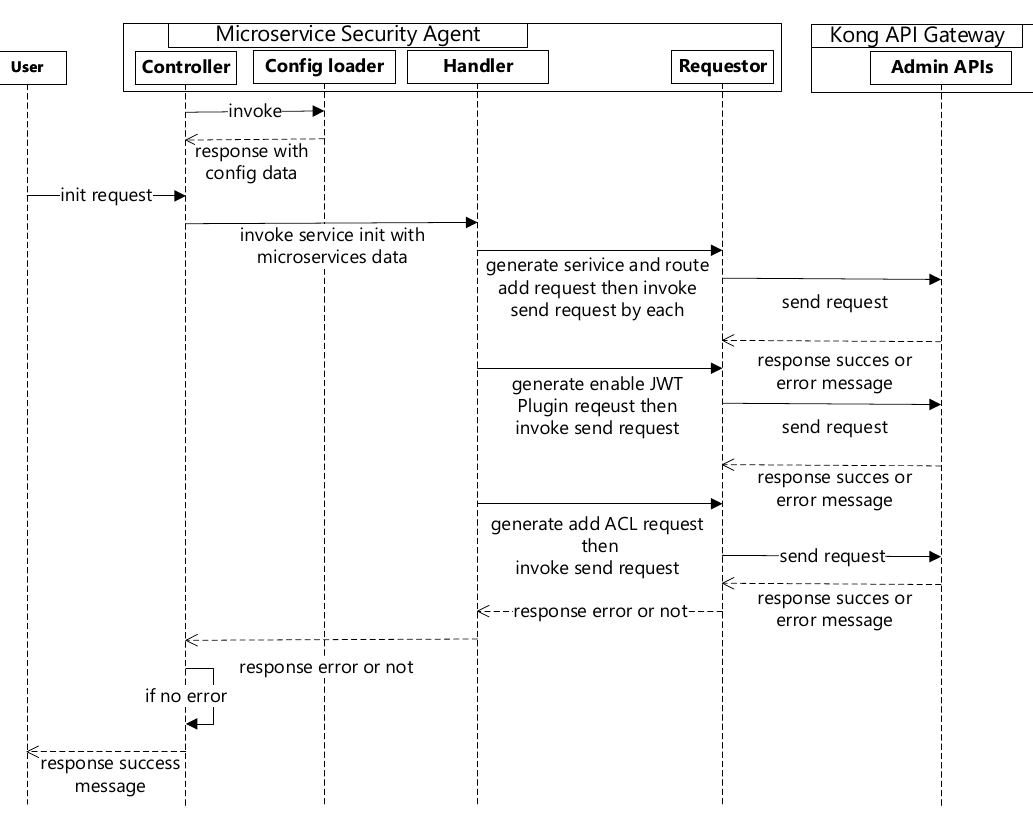
Figure 3. Sequence diagram for microservice security